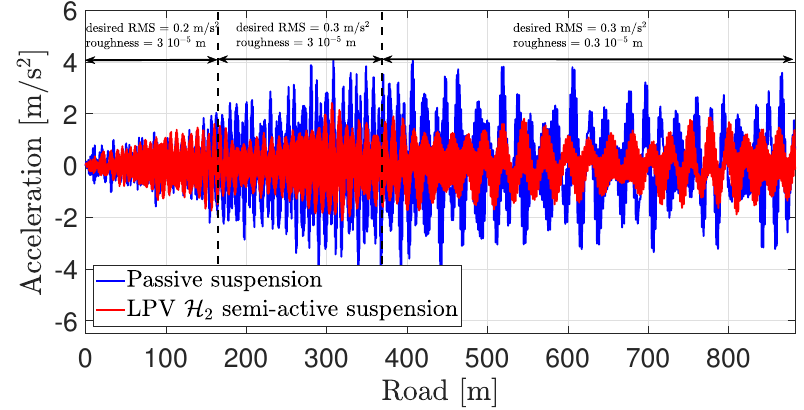
Figure 28. Resulting acceleration felt by passengers (filtered by